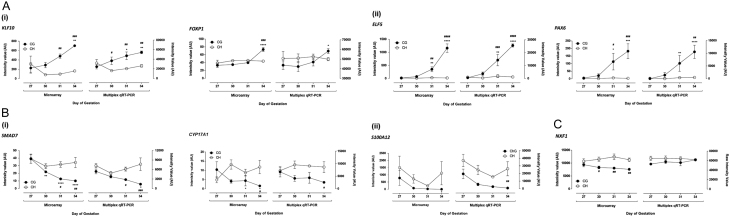
Validation of microarray data using multiplex qRT-PCR. 8 genes selected from microarray data were validated in expression via multiplex qRT-PCR. Microarray data is plotted on the left hand axes, alongside multiplex qRT-PCR data plotted on the right hand axes of each pair of graphs. All fold changes are shown compared with day 27 chorionic girdle. (A) Genes selected for validation with an upregulation (i) 2–5 fold and (ii) >20 fold, in the chorionic girdle between days 27 and 34 of pregnancy in microarray data. (B) Genes selected for validation with a downregulation (i) 2–5 fold and (ii) >20 fold, in the chorionic girdle between days 27 and 34 of pregnancy in microarray data. (C) Gene selected with no change in the chorionic girdle between days 27 and 34 of pregnancy, based on microarray data. *P < 0.05, **P < 0.01, ***P < 0.001, ****P < 0.0001 (compared to day 27 chorionic girdle), #P < 0.05, ##P < 0.01, ###P < 0.001, ####P < 0.0001 (compared to chorion at same time point) (two-way ANOVA).